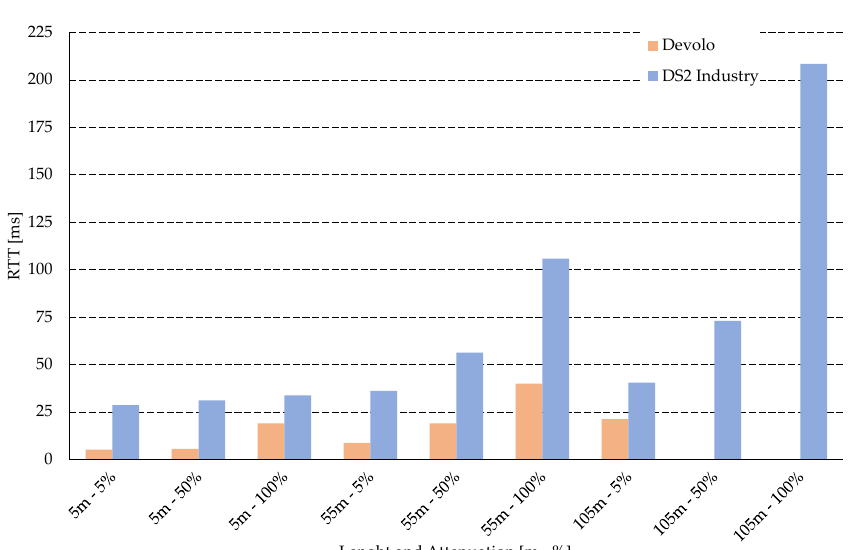
Figure 4. Round Trip Time